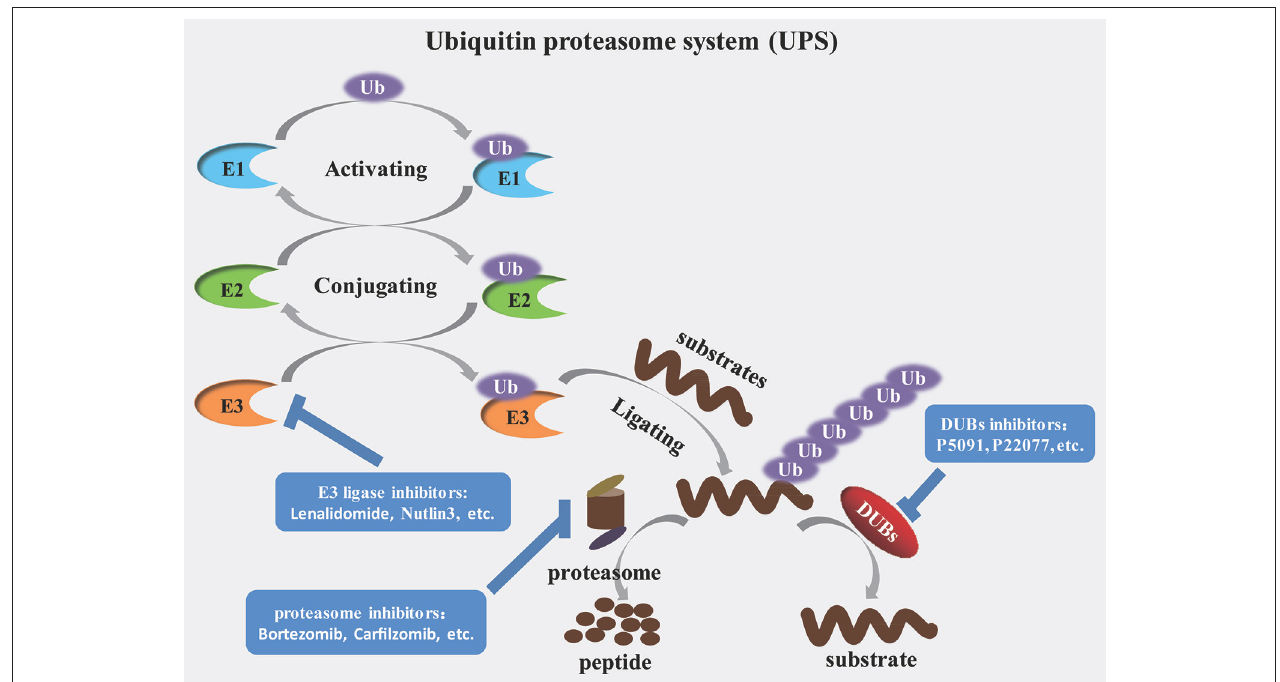
FIGURE 1 | The ubiquitination, degradation and deubiquitination process of protein substrates Ubiquitin is activated by E1 activating enzymes and then, in turn, transferred to E2 conjugating enzymes and E3 ubiquitin ligases. E3 ubiquitin ligases specifically recognize and catalyze the substrate, ultimately leading to the degradation of substrates through the proteasome or stabilization of target proteins through relevant DUBs.